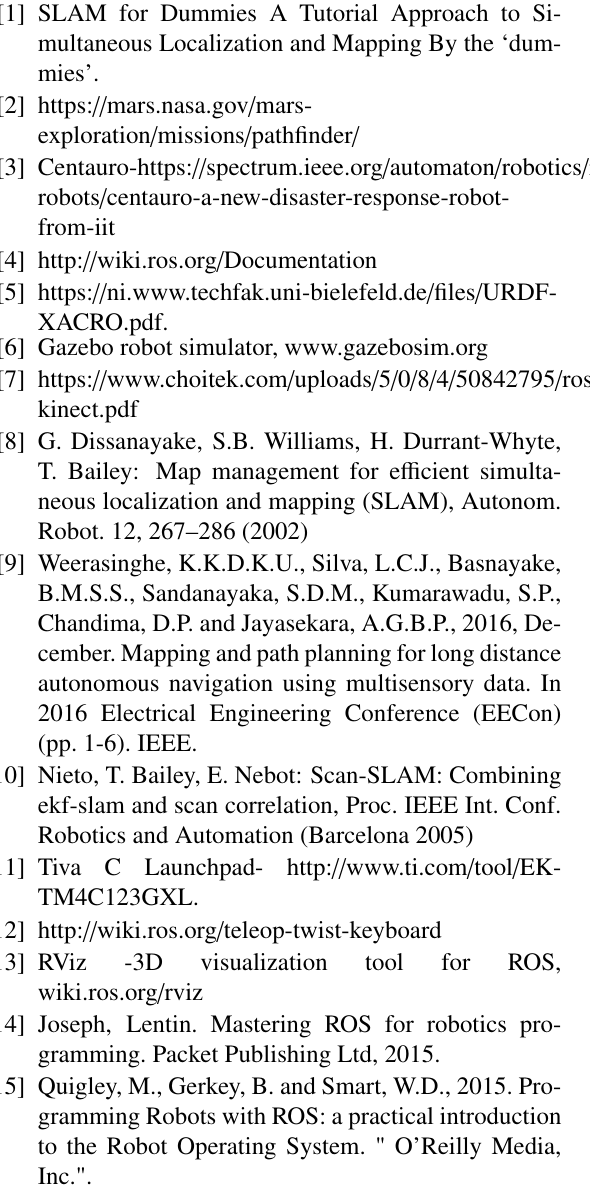
Figure 11. Robot reaching goal through amcl